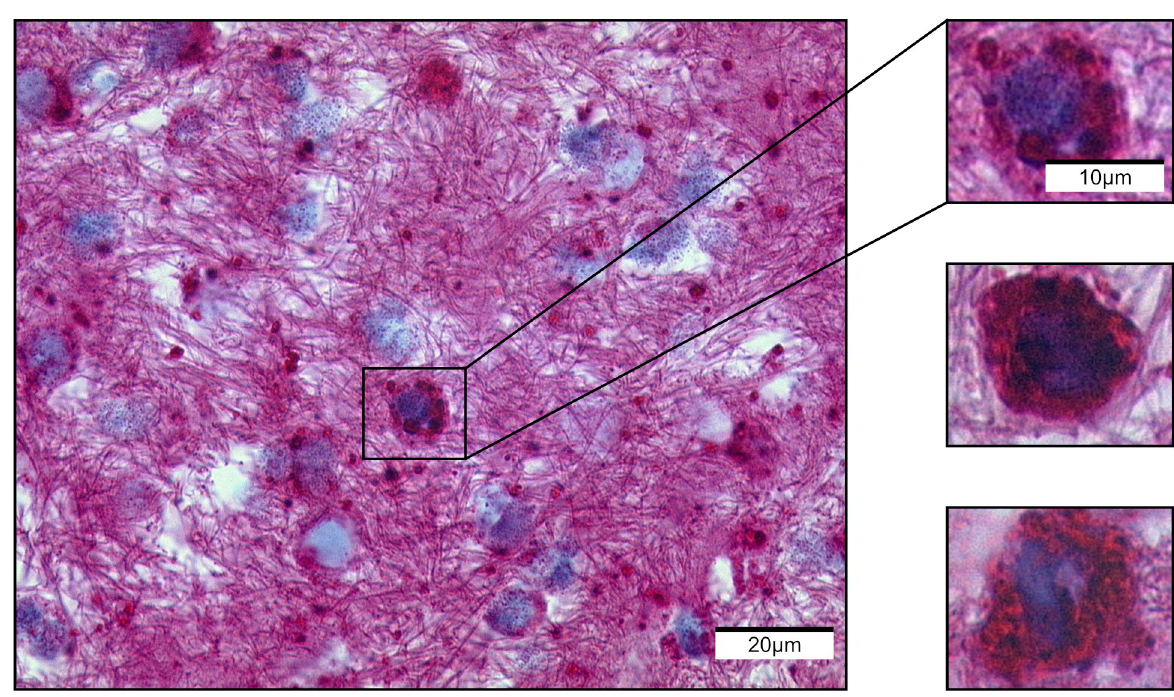
Fig 2. Immunochemistry with mAb EmG11 of a pleural effusion. Staining shows macrophages with intracytoplasmic spems.